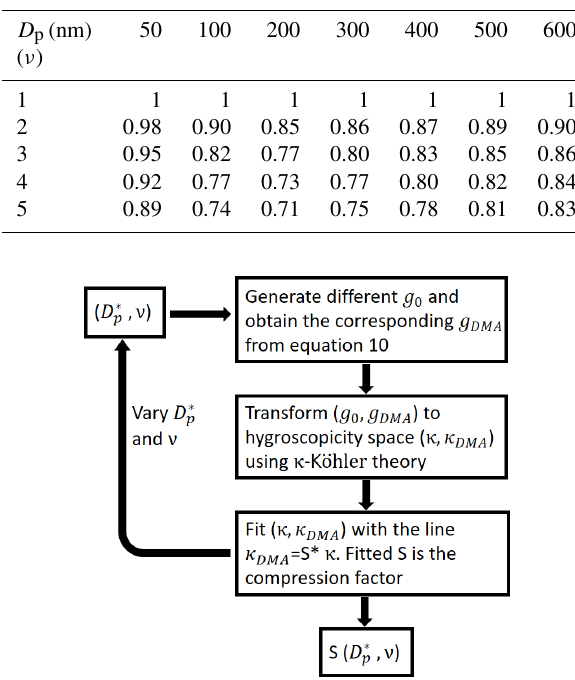
Figure 4. The algorithm for calculating the compression